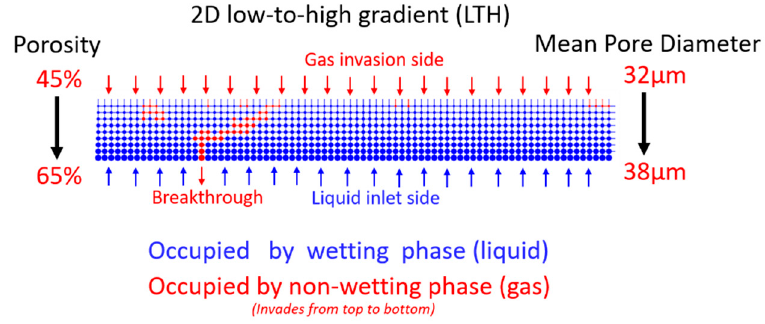
Figure 3. Visualization of the pore structure gradient in a 2D pore network. Here, the low-to-high (LTH) gradient is illustrated. It is shown how the structure can be occupied by gas (non-wetting) and liquid (wetting) phases simultaneously.